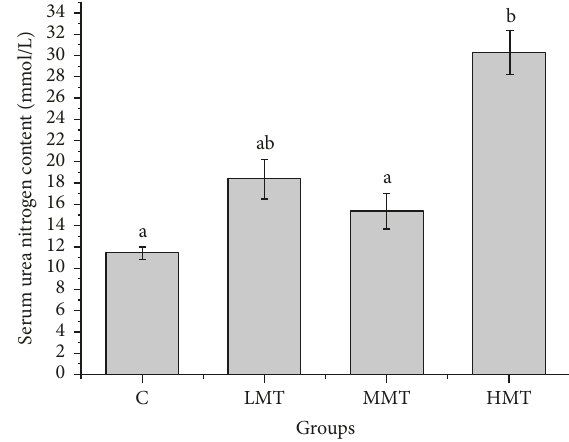
Figure 3: Effect of Xinjiang maca on serum urea nitrogen content (C, control; LMT, low-dose maca-treated group; MMT, medium- dose maca-treated group; HMT, high-dose maca-treated group. Each value represents the mean ± SD ( 𝑛 = 10 ). Different letters indicate significant differences among groups ( 𝑃 < 0.05